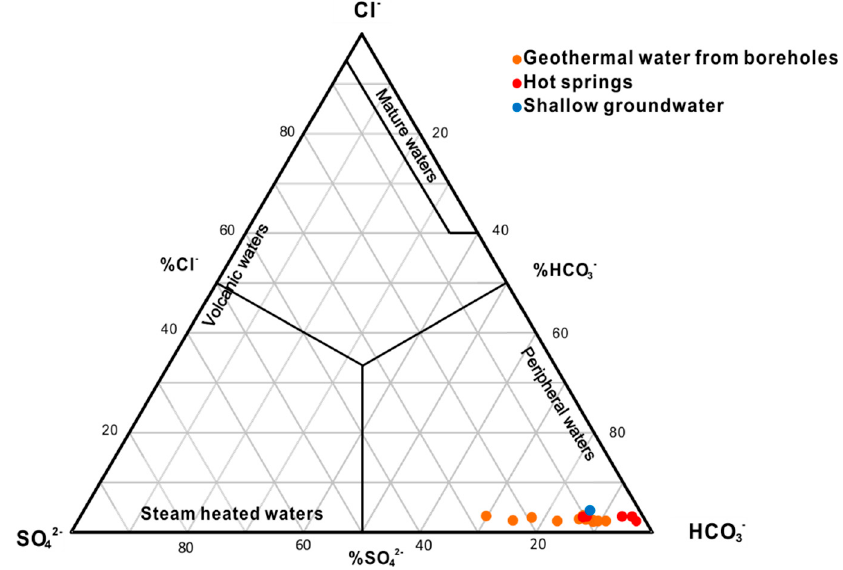
− ternary plot for the water samples 2 − -HCO 3 4